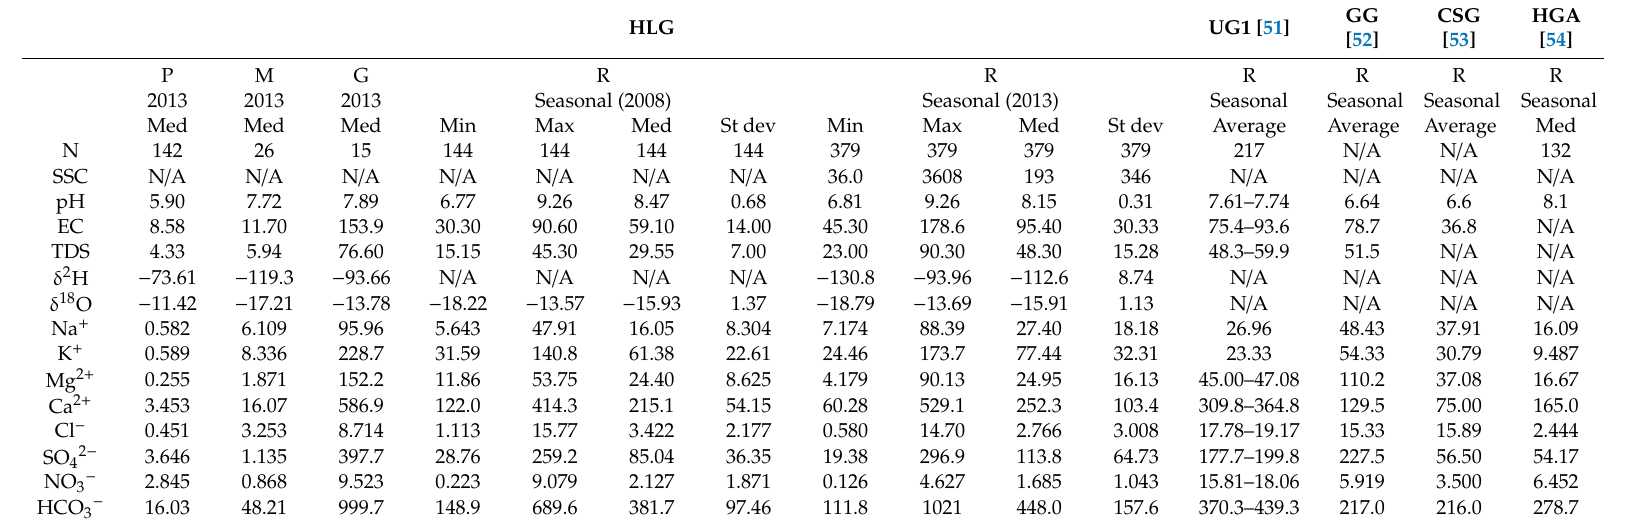
Table 3. Median (Med), maximum (Max) and minimum (Min) concentrations or values of pH, electrical conductivity (EC; µ S · cm − 1 ), total dissolved solids (TDS; (G) and river water (R) at the Hailuogou basin (HLG) over two melt seasons in 2008 and 2013, in comparison to Urumqi Glacier No.1 (UG1) in the Tianshan Mountains, Gangotri Glacier (GG) and Chhota Shigri Glacier (CSG) in the Himalaya Mountains, and Haut Glacier d’Arolla (HGA) in Switzerland. N / A denotes data are not